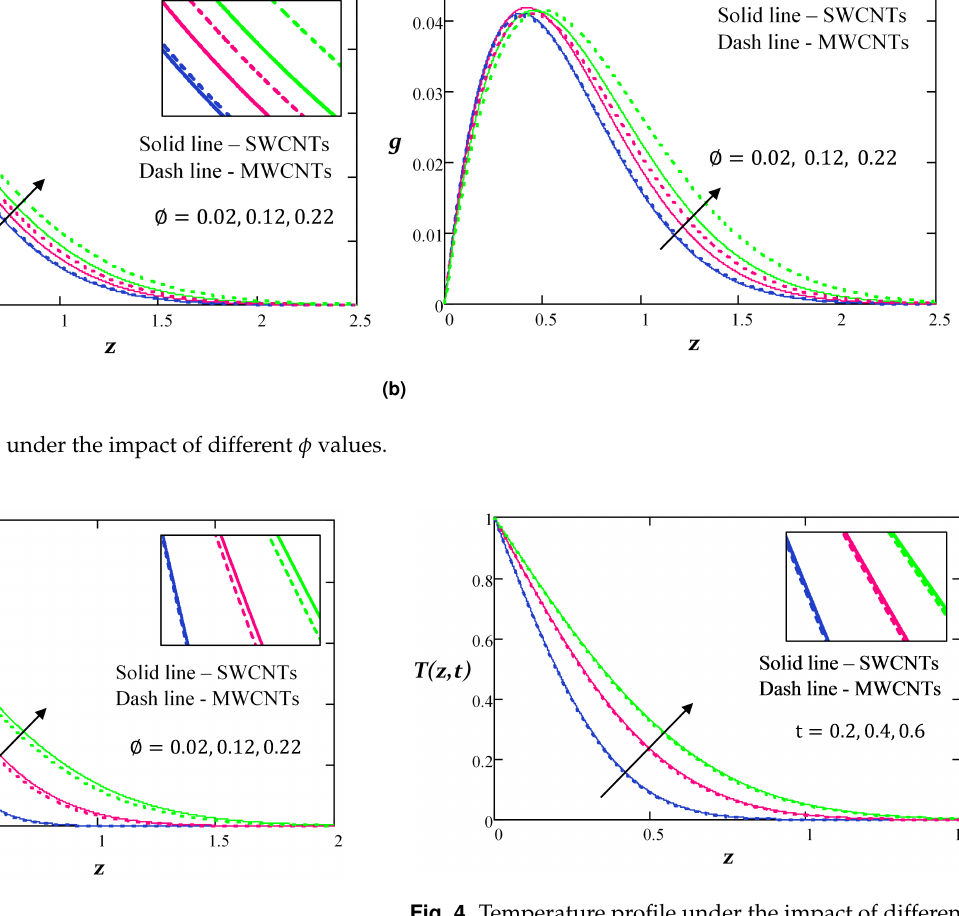
Fig. 3. Temperature profile under the impact of different φ values.